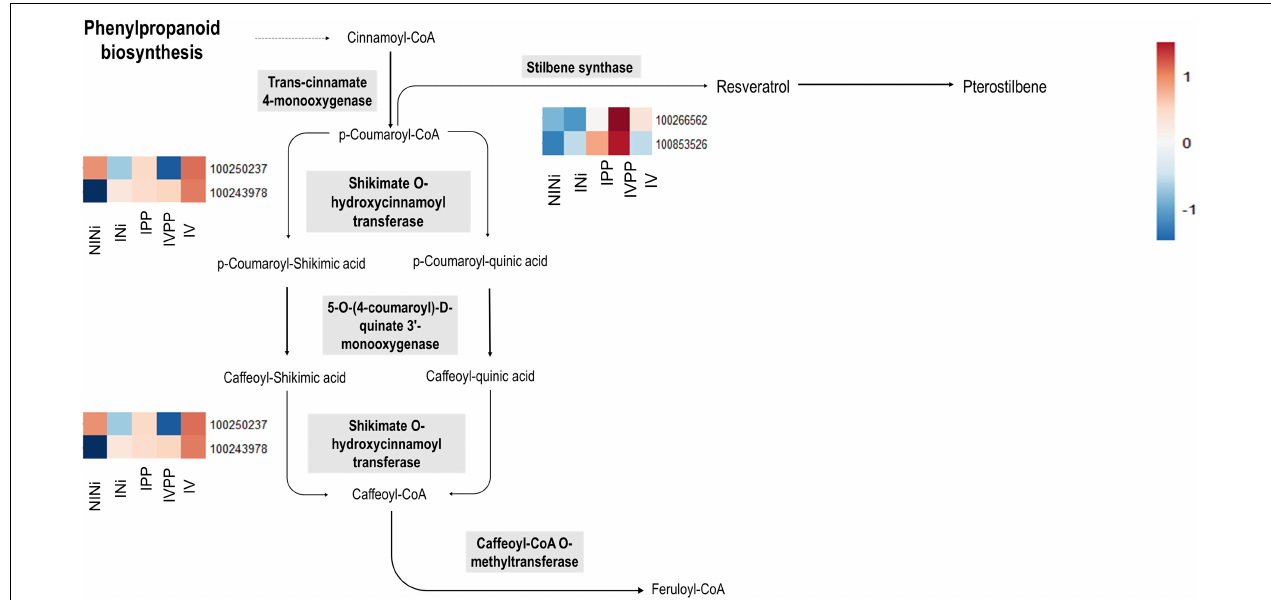
FIGURE 5 | Schematic representation of stilbene biosynthesis (Adapted from KEGG Pathways). The heatmap represent the expression profile of the identified DEGs associated to the ENTREZ IDs of the enzymes implicated in this biosynthesis pathway. The color key represents the log2 relative gene expression values. Each line represents one gene, and each column represents one